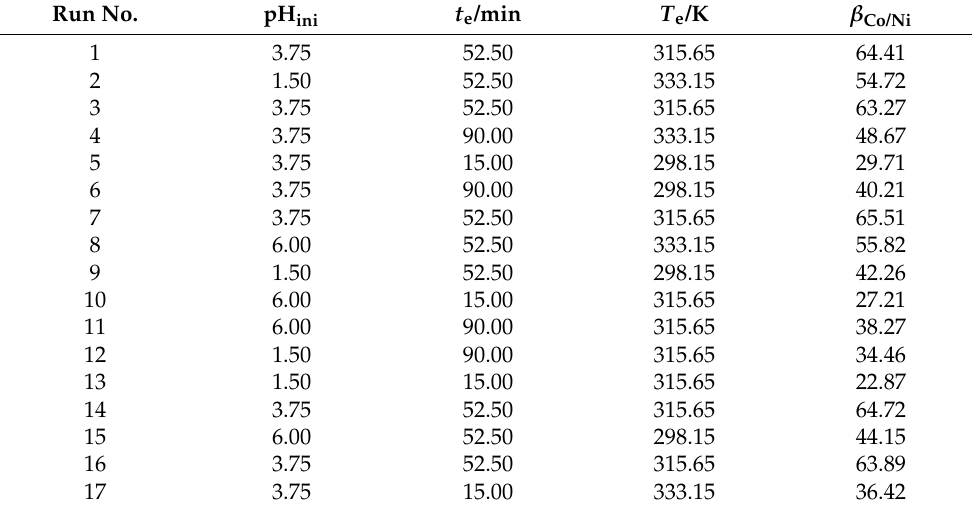
Table 2. Box–Behnken design for independent variables and observed responses. Run